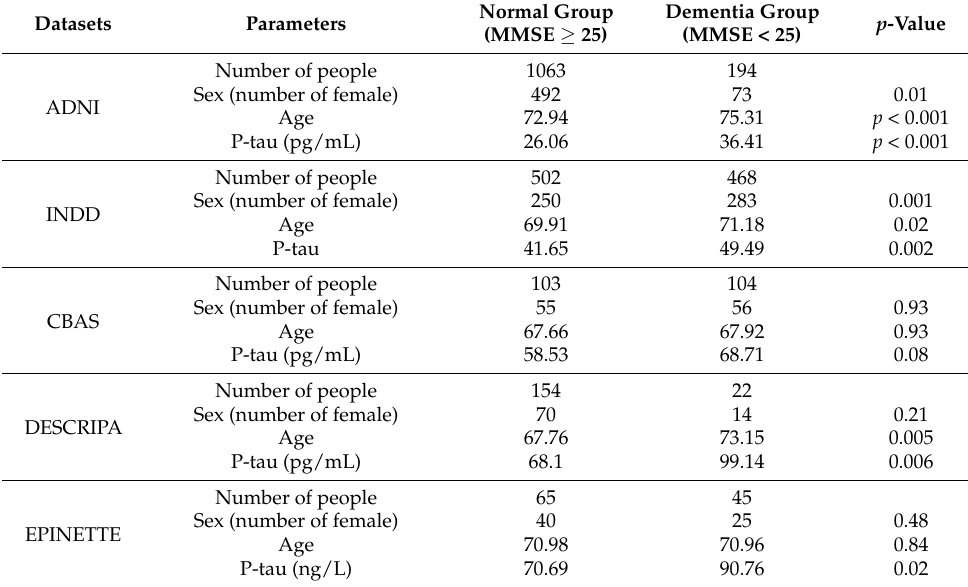
Table 3. Differences of CSF p-tau level between dementia patients and healthy people in all 5 datasets. p -Values < 0.05 indicated that the difference is